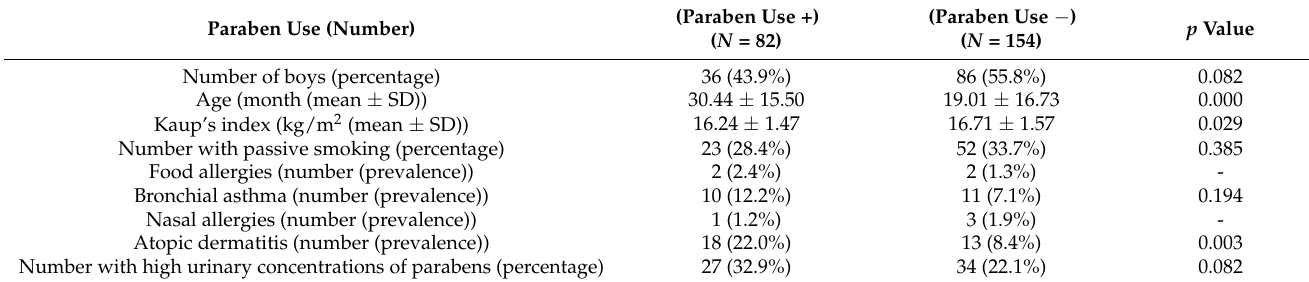
Table 3. Comparisons of prevalence of allergic diseases between children with and without paraben